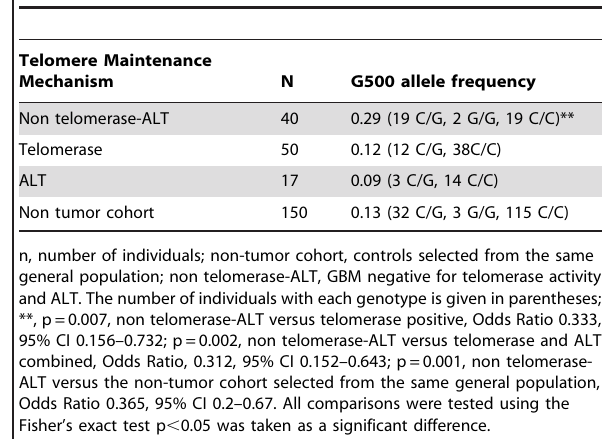
Table 2. The G500 allele is more frequent in GBMs without a definitive telomere maintenance